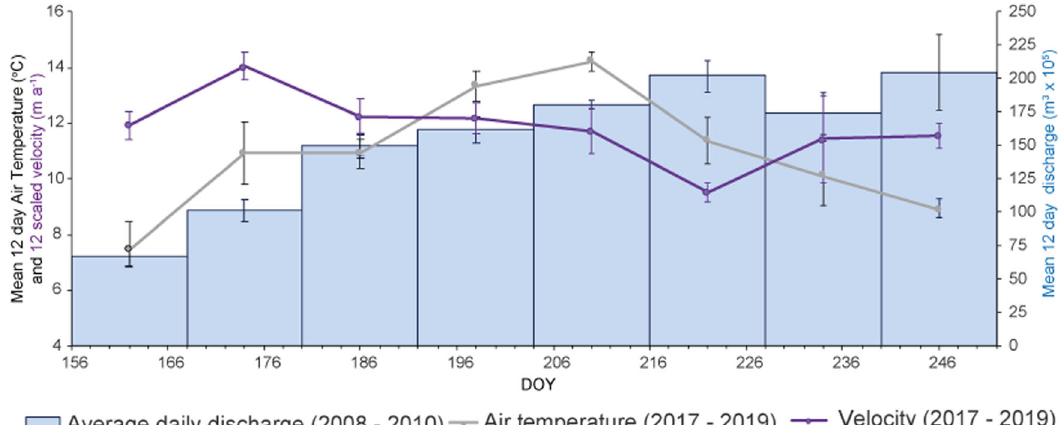
Fig. 6 Summer data. Mean 12-day summer scaled velocity data against 12-day daily mean air temperatures for summer 2017 – 19, and mean 12-day scaled discharges for summer 2008 – 2010 (Skálafellsjökull) (error bars represent the standard deviation of the 2-year data set).